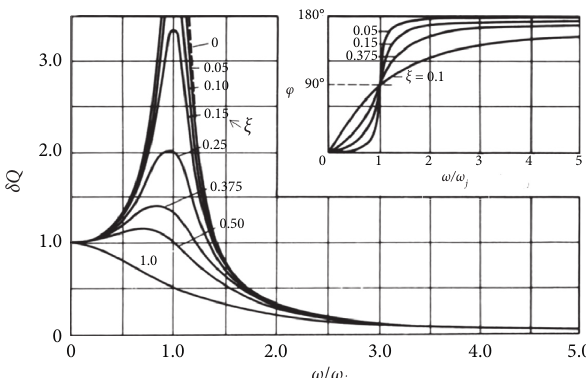
Figure 5: Amplitude amplification coefficient and phase shift angle of mode shapes.